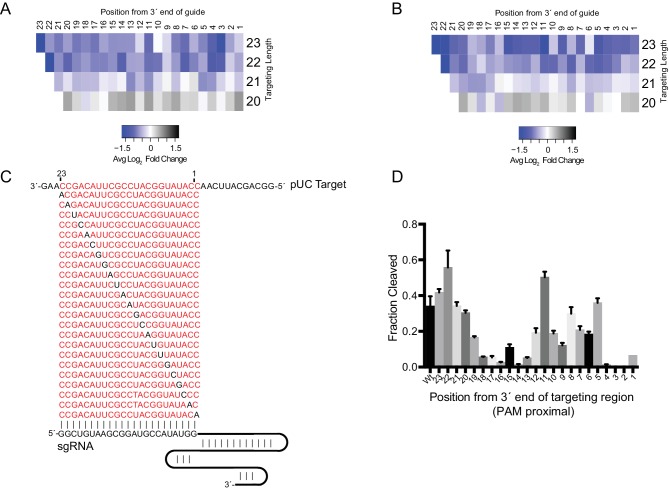
Effect of single-nucleotide mismatches on ssRNA targeting.(A–B) Heatmap of average log2 fold-change for all single-nucleotide mismatch (SNP) guides in MOI-10 (A) and MOI-100 (B) treatment. Deeper blue represents greater negative selection of guides indicating greater sensitivity to mismatches at that position. While deeper black represents greater positive selection indicating that mismatches at that position are more tolerated. Positions are given as distance from 3´ end of the targeting region of the sgRNA. (C) Diagram of target ssRNAs with SNPs for in vitro cleavage assays. Red highlights the region complementary to the guide while black nucleotides indicate the mismatched base in the targeting region. Numbering of nucleotides is labeled from 1 to 23 to reflect positions in (A) and (B). (D) Quantification of in vitro cleavage assays with mismatched targets in (C). Bars represent the mean ± S.D. (n = 3). ‘Wt’ indicates 23nt of perfect complementarity between the sgRNA and the target.10.7554/eLife.32724.024Figure 3—figure supplement 4—source data 1.Heatmaps of single-nucleotide mismatches from MS2 screen and in vitro mismatch cleavage.